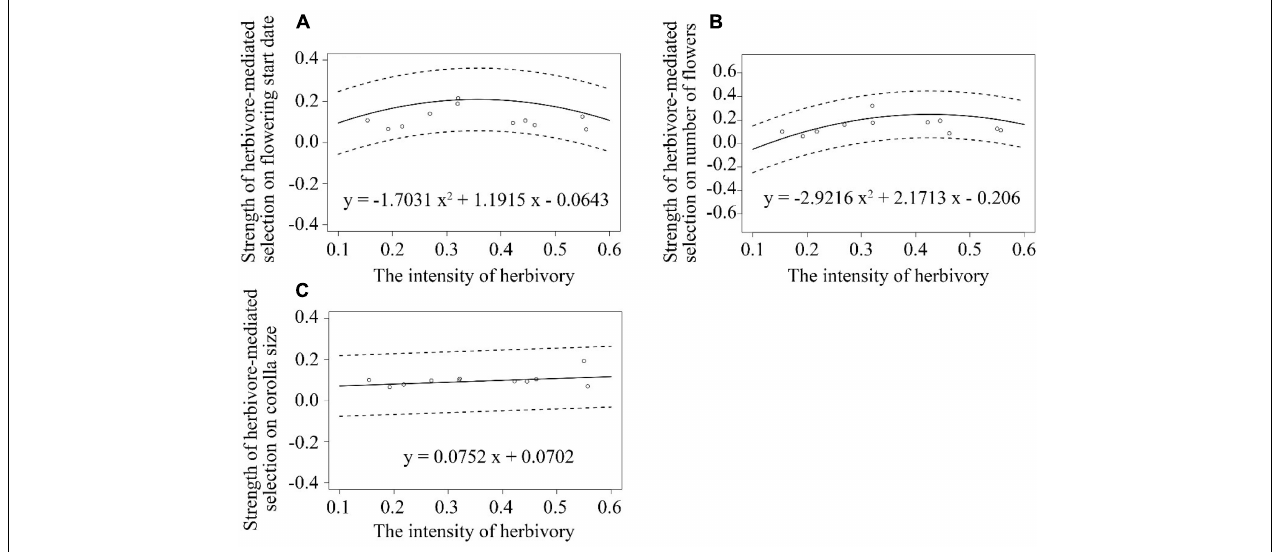
FIGURE 5 | Associations between the strength of herbivore-mediated selection on: (A) flowering start date (B) number of flowers (C) corolla size per plant and the intensity of herbivory among 11 populations of Primula florindae . The best-fit models for each trait are also provided. The dashed lines represent the 95% confidence interval of the fitted